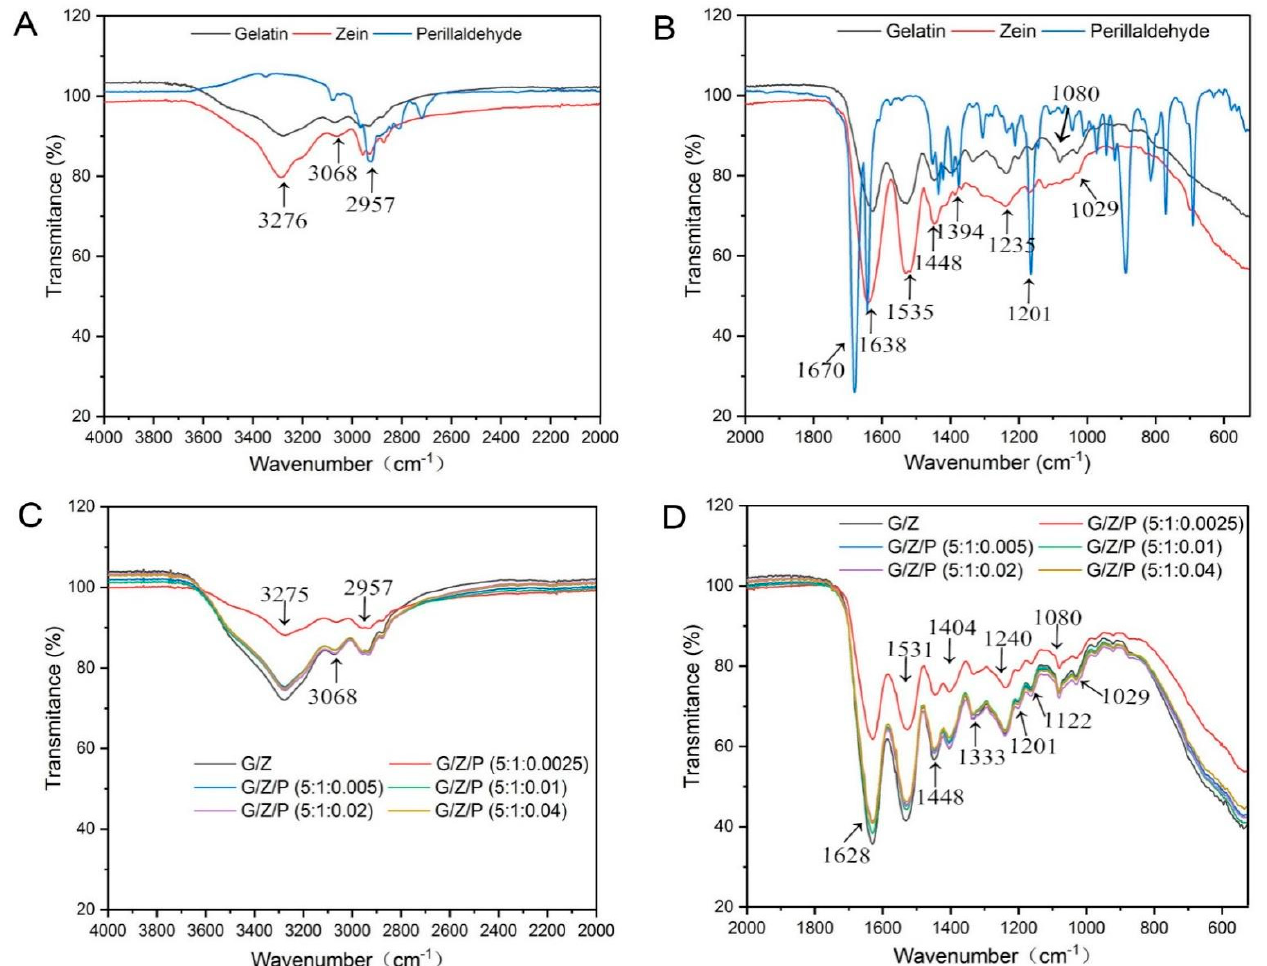
Figure 4. FTIR spectra of polymer monomers of gelatin, zein and perillaldehyde ( A, B ) and the gelatin/zein/perillaldehyde nanofiber films ( C, D ).